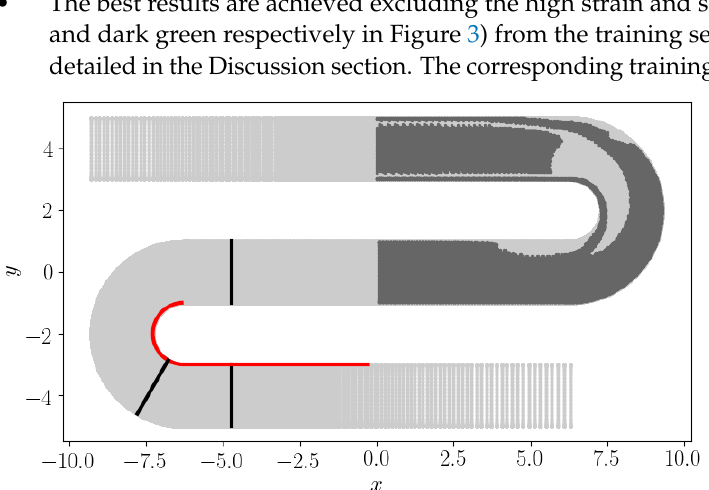
Figure 6. Training regions highlighted in dark grey and location of velocity (black lines) and wall shear stress (red line)